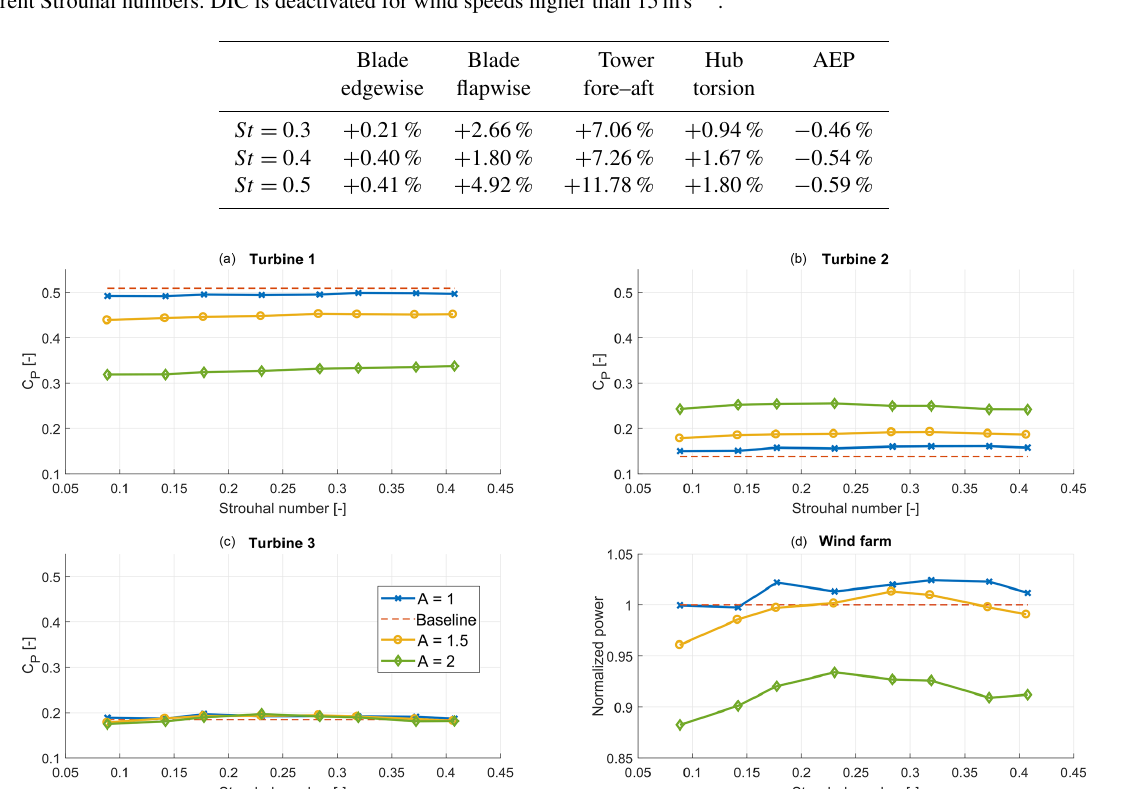
, as defined in Table 2. Panel ( d ) shows the total power T